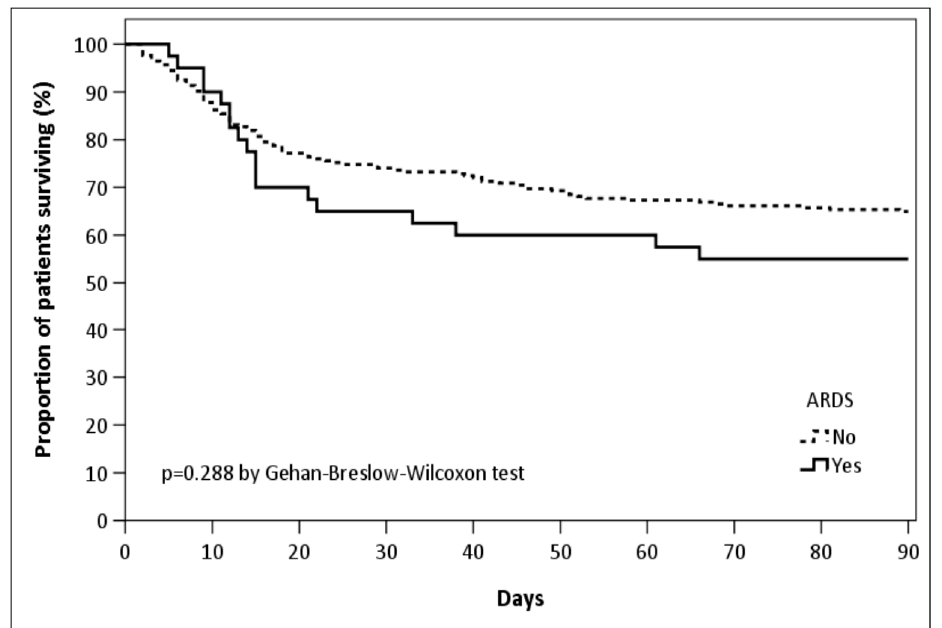
Figure 2. Kaplan–Meier survival curves at 90 days.